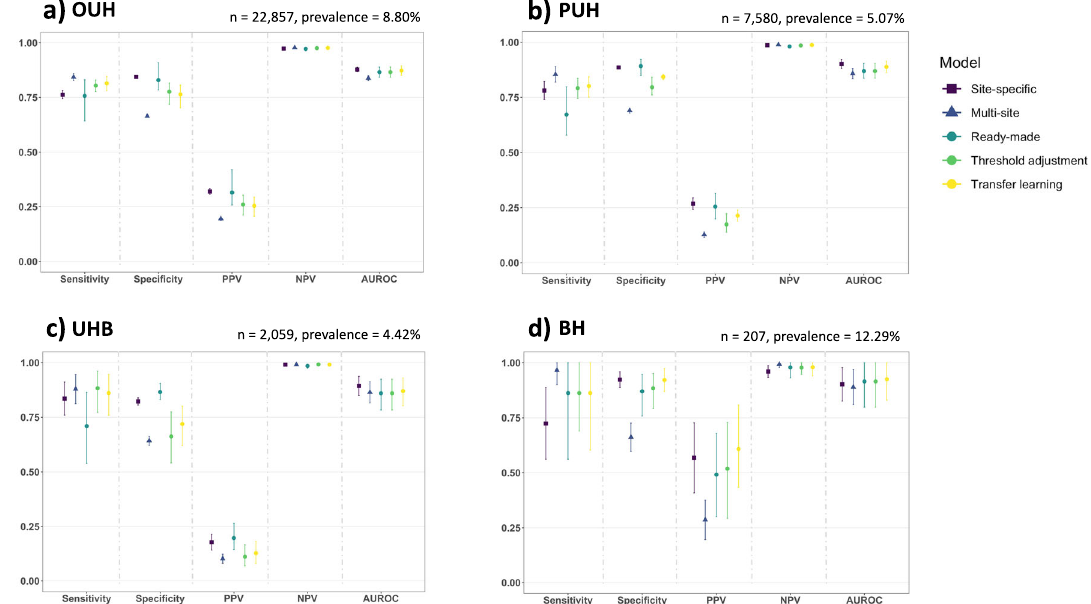
Fig. 2 Mean classi fi cation performance of different model-implementation methods. Panels compare each implementation method (ready- made, threshold adjustment, transfer learning) and baseline models (site-speci fi c and multi-site), across four NHS Trusts: a OUH, b PUH, c UHB, and d BH (numerical results are shown in Supplementary Tables S4, S5). All models were optimized during training and validation to achieve sensitivities of 0.85 (optimal thresholds can be found in Supplementary Table S6). Error bars show 95% con fi dence intervals (CIs) based on standard error. CIs for AUROC are calculated using Hanley and McNeil ’ s